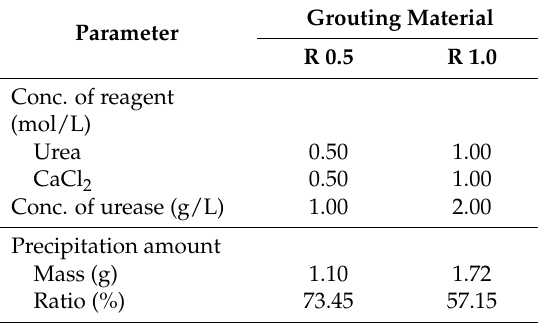
Figure 3. Precipitation ratio results for several concentrations of urease [10,33]. Table 2. Selected grouting materials.